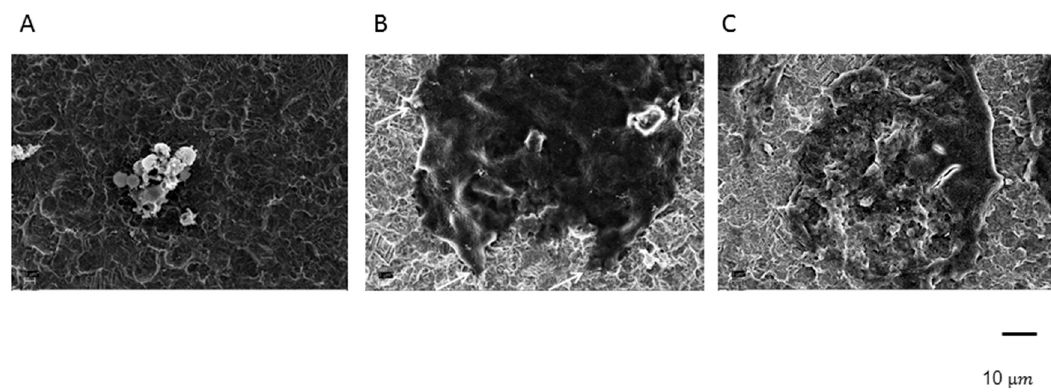
Figure 5. Scanning electron microscopy of PBMC -M-CSF/RANKL ( A ), PBMC +M-CSF/RANKL ( B ), and PBMC +M-CSF/RANKL + DMAB (cDMAB) ( C ), all on titanium.